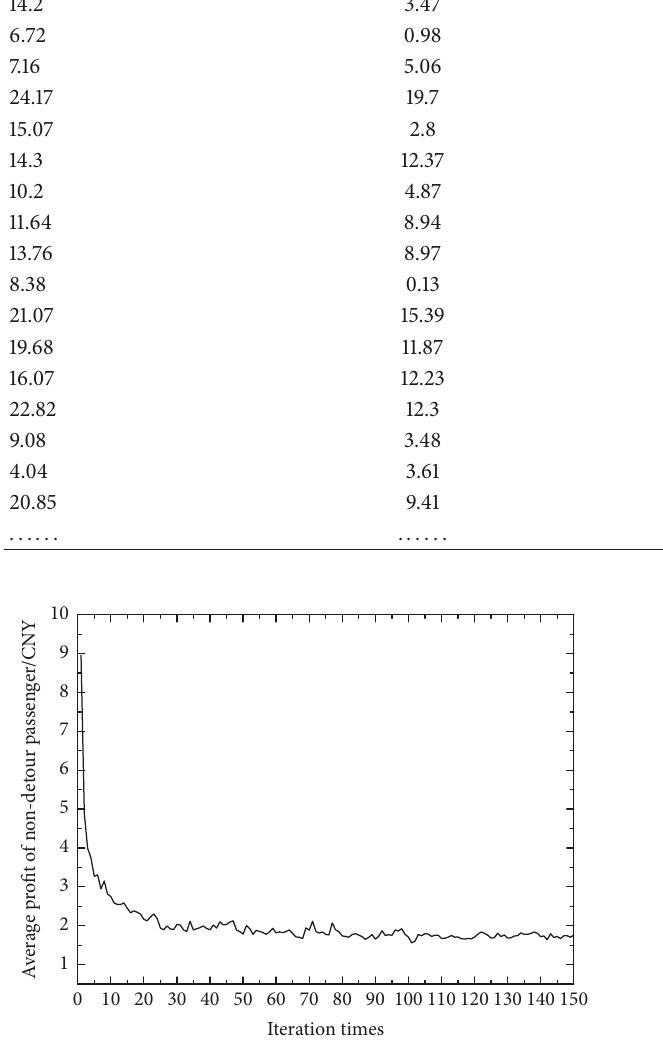
𝐵 ’s average profit.